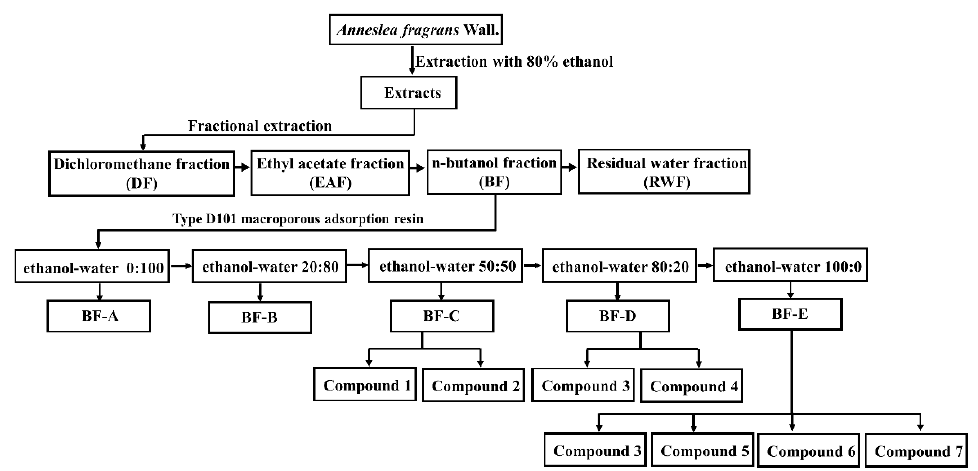
Figure 5. Extraction and isolation procedure of the compounds from 80% aqueous ethanol extract from Anneslea fragrans